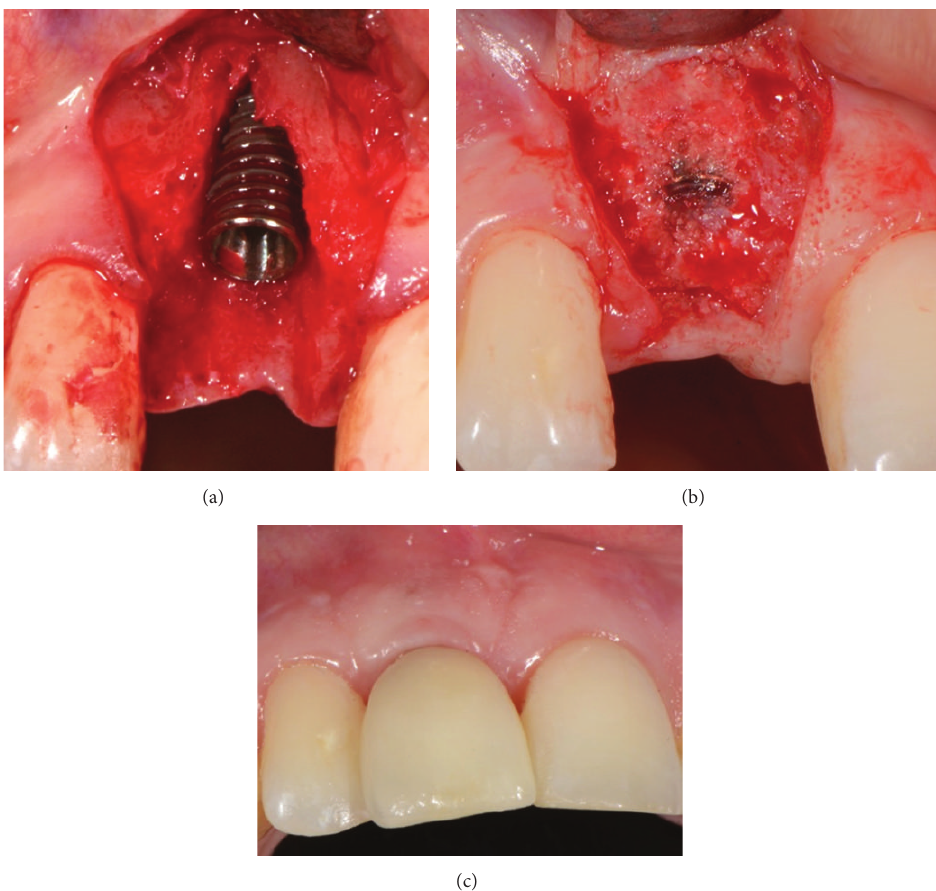
Figure 4: Case 2: a 28-year-old woman with root fracture in the maxillary right central incisor. (a) Implant placed at the optimum 3D positioning leaving a buccal dehiscence. (b) Reentry after 10 weeks revealing complete bone regeneration of the site. The head of the implant is partially covered by newly formed bone and the ridge is also significantly augmented laterally. ISQ reading was 75. (c) Six months after loading, excellent preservation of the buccal profile.